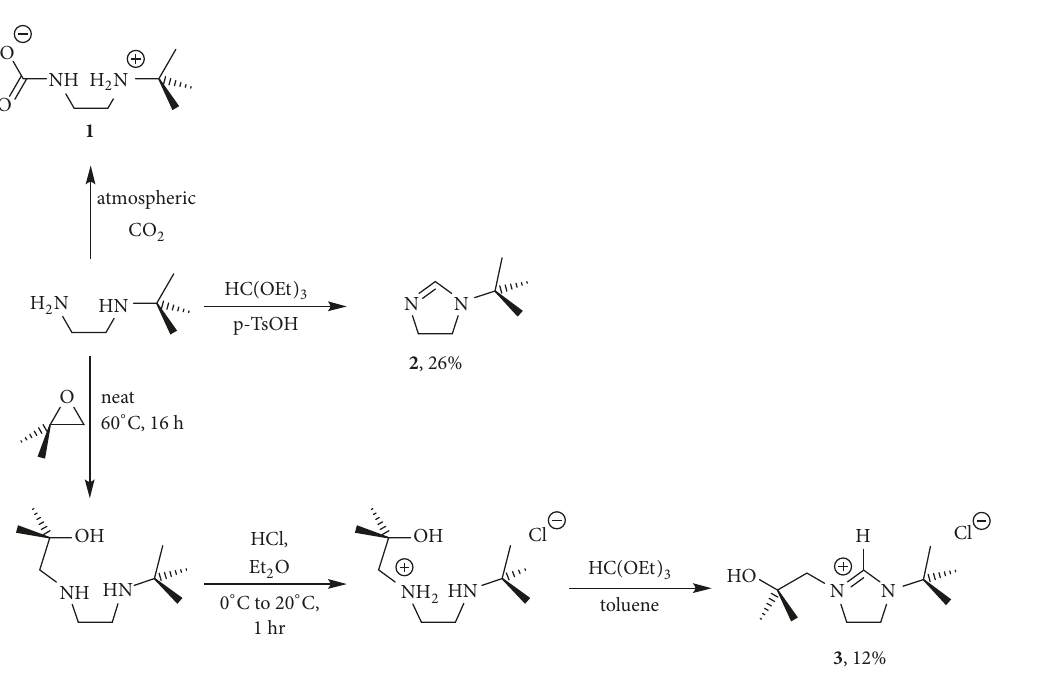
Scheme 1: Reactions of N- tert